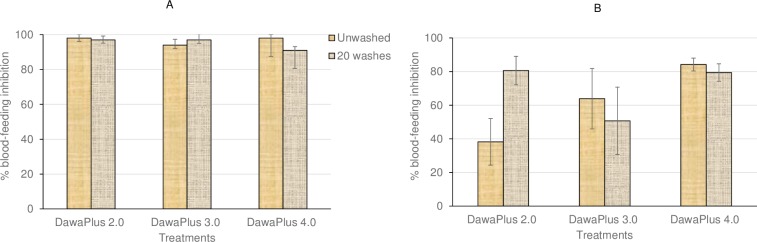
Blood-feeding inhibition rate of An. gambiae Kisumu (A) and An. gambiae s.l. (emerged from field-collected larvae) (B) in tunnel tests with different treatments relative to the untreated control. The bars show blood-feeding inhibition rate of unwashed and 20-times washed nets. Error bars represent 95% confidence intervals.